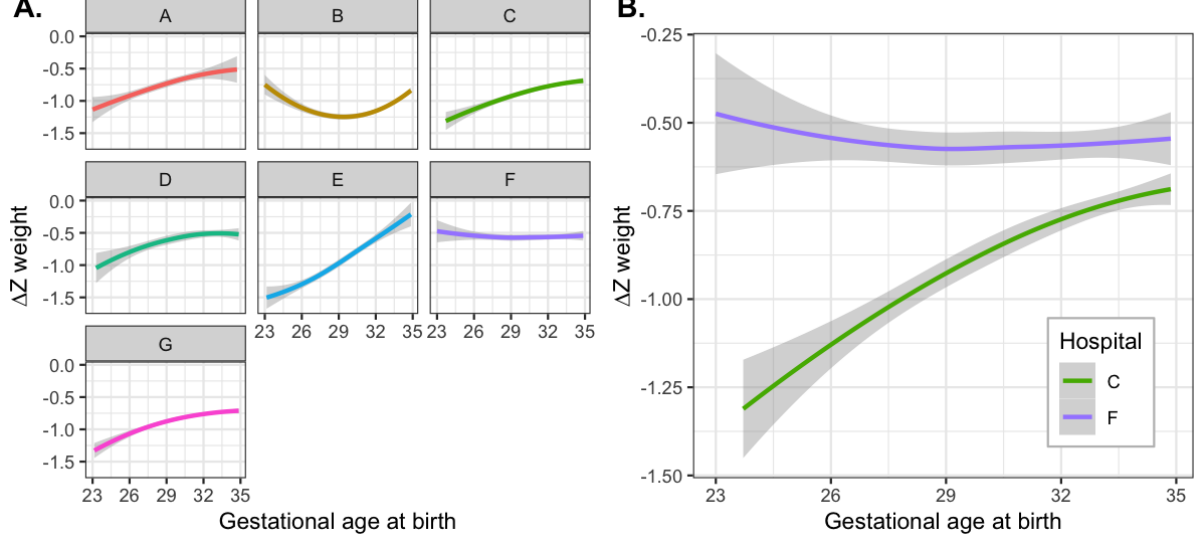
Figure 6. Inter-hospital variation in change in weight Z-score from birth to discharge, as related to gestational age at birth, (A) separately for each of seven different hospital NICUs in Massachusetts, and (B) for hospitals C and F overlaid on the same plot to better demonstrate inter-hospital